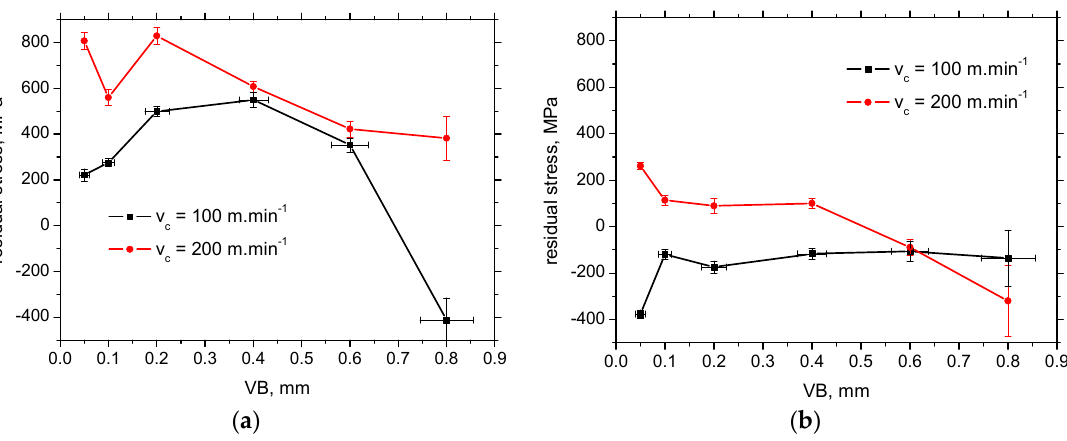
Figure 6. Evolution of surface residual stresses with VB : ( a ) CD; ( b ) FD. A more systematic behaviour can be found for the depth extent of residual stresses, see Figure 7. Residual stresses penetrate deeper along with the increasing VB, and the maximum compressive stresses are greater. On the other hand, the remarkable relaxation of residual stresses can be found for VB = 0.6 mm due to the aforementioned decrease in WL thickness linked with the mentioned alterations in the cutting-edge geometry [28]. This cutting-edge alteration also makes the maximum compressive stresses for VB = 0.8 mm lower as compared with that for VB = 0.4 mm.